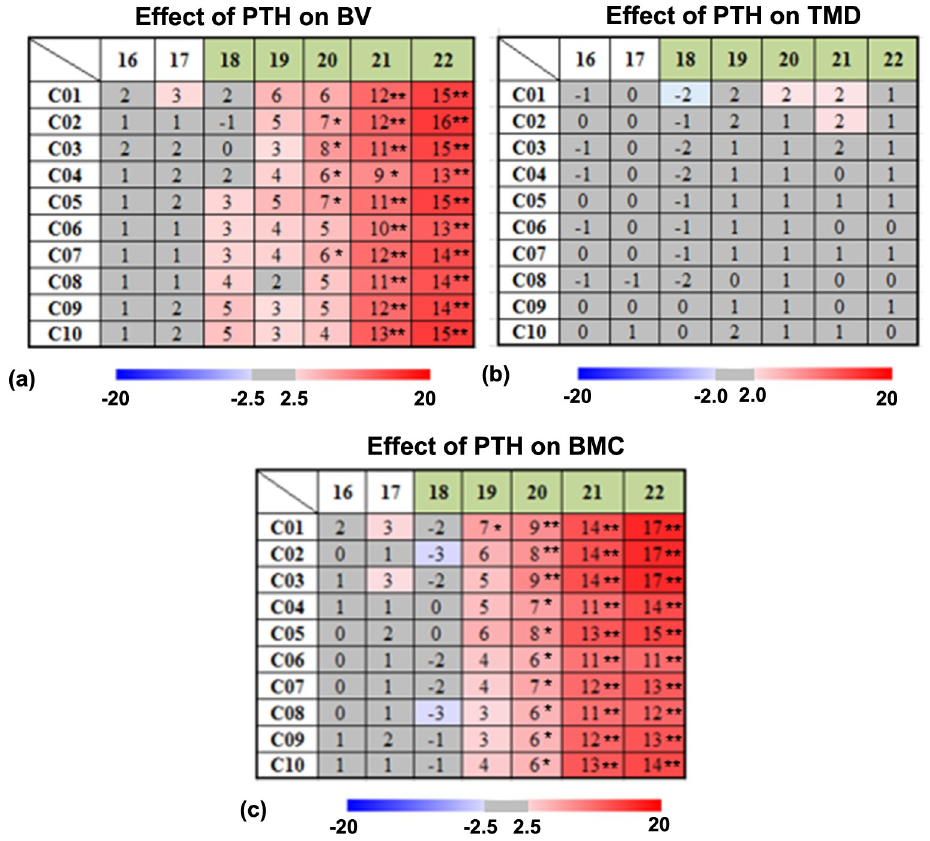
Fig 2. Longitudinal effects of PTH treatment on tibial BV, TMD and BMC in the spatiotemporal space. The data are presented as the mean relative percentage difference ( δ D% j ) (Eq 1) between the Wild and WildPTH groups for the 10 compartments along the proximal-distal tibial axis ( � p < 0.05, �� p < 0.01) (intermittent PTH treatment started in week 18 and lasted until week 22, which is labeled in green in the